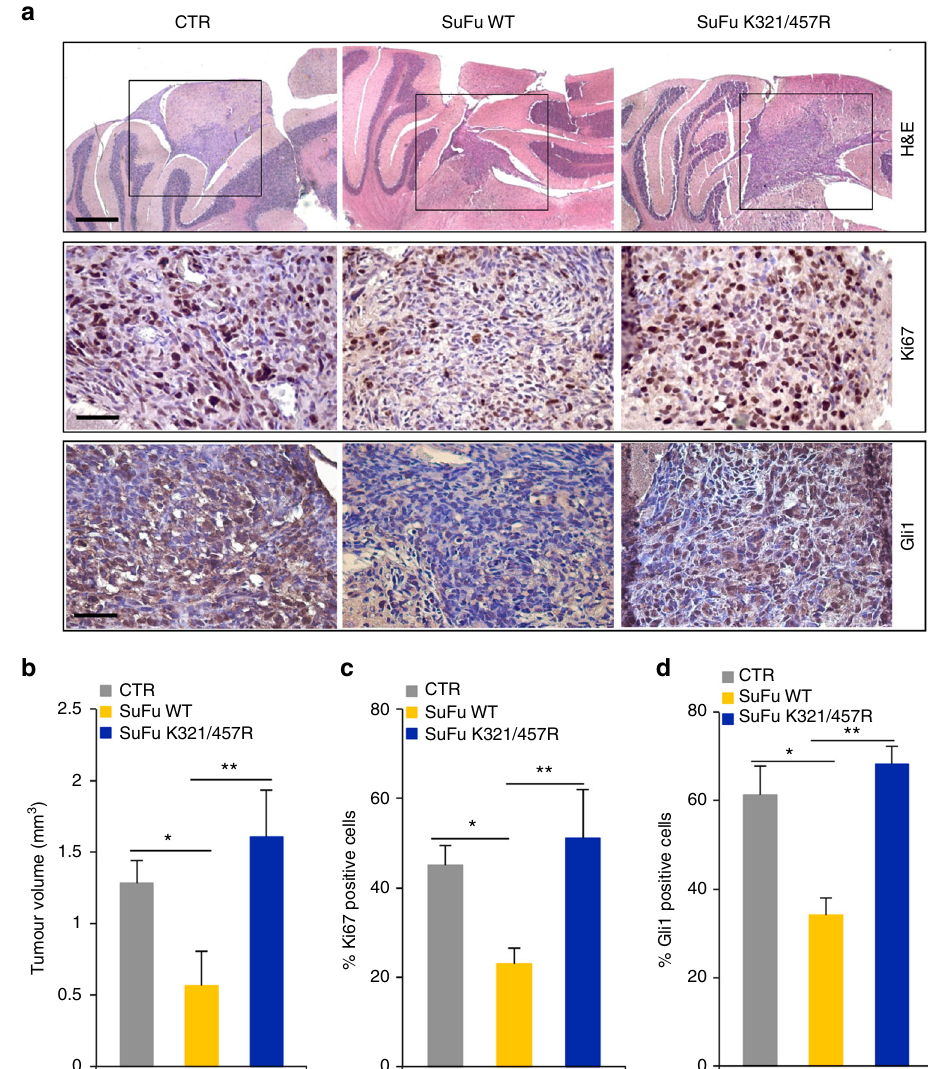
Fig. 7 Human Daoy orthotopic MB xenografts. a Representative images of haematoxylin and eosin (H&E), Ki67, and Gli1 immunohistochemical stainings of a human Daoy MB cell-derived orthotopic tumour in NOD/SCID mice ( n = 6 mice for each group, CTR, SuFu WT, and SuFu K321/457R). Scale bars represent 500 µ m for H&E staining and 50 µ m for Ki67 and Gli1 stainings. b Representative tumour average volumes after explantation. c , d Quanti fi cation of Ki67 ( c ) and Gli1 ( d ) stainings from immunohistochemistry shown in ( a ). *P < 0.01, SuFu WT versus CTR; * *P < 0.01, SuFu K321/457R versus SuFu WT. Error bars indicate SD. P -values were determined using Mann – Whitney U